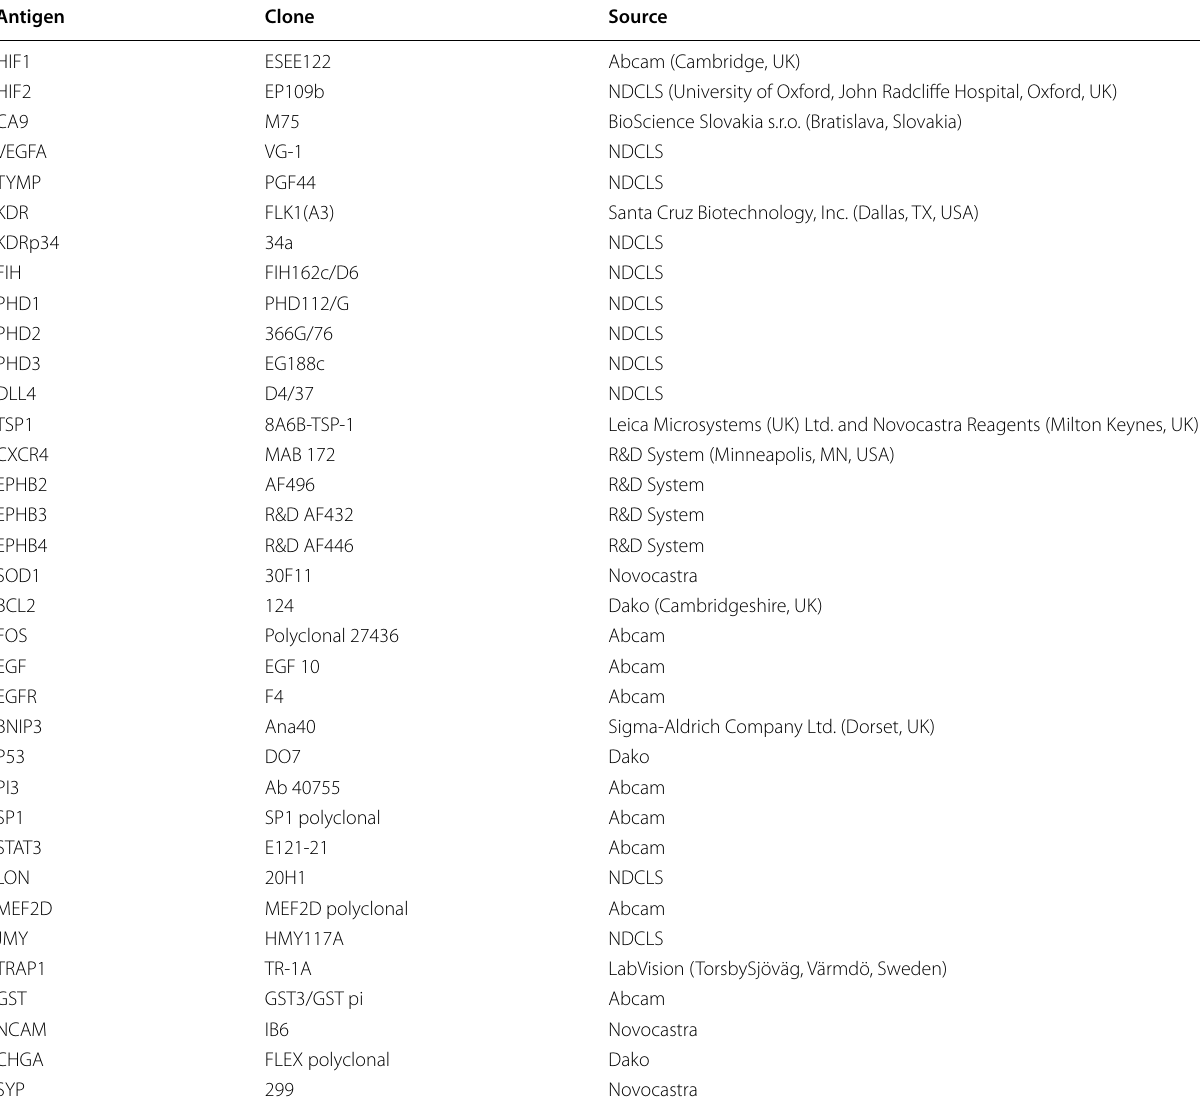
Table 1 Antibodies used for